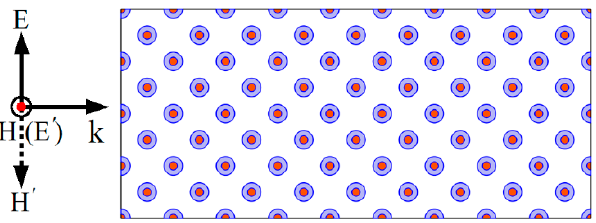
Figure 1. Schematic of a two-dimensional plasma photonic crystal. YIG rods (red), plasma (violet). Solid lines represent TE (0,0, H z ) polarization and dashed lines represent TM (0,0, E z )